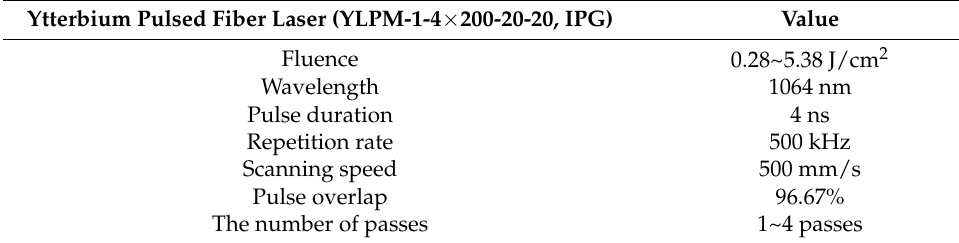
Table 2. Laser parameters used in experiments.